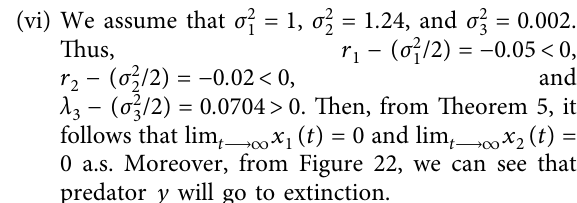
( v, σ 2 ) and its phase plan ( i � 1 , 2 , 3 ) (color figure online): (a) k i i ( v, σ 2 ) , and (f) phase plan of k 2 2